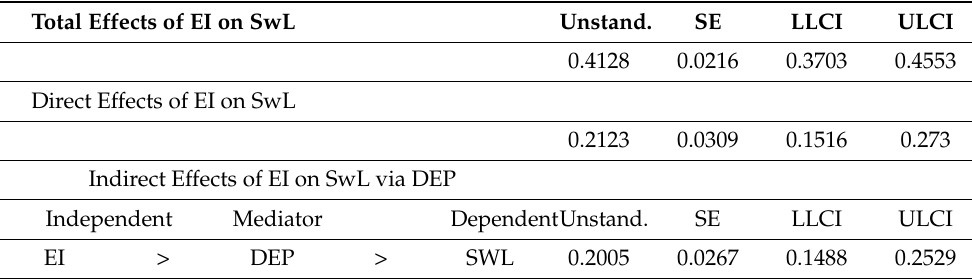
Table 5. Total, Direct and Indirect Effects of Emotional Intelligence (EI) on SwL. Total Effects of EI on